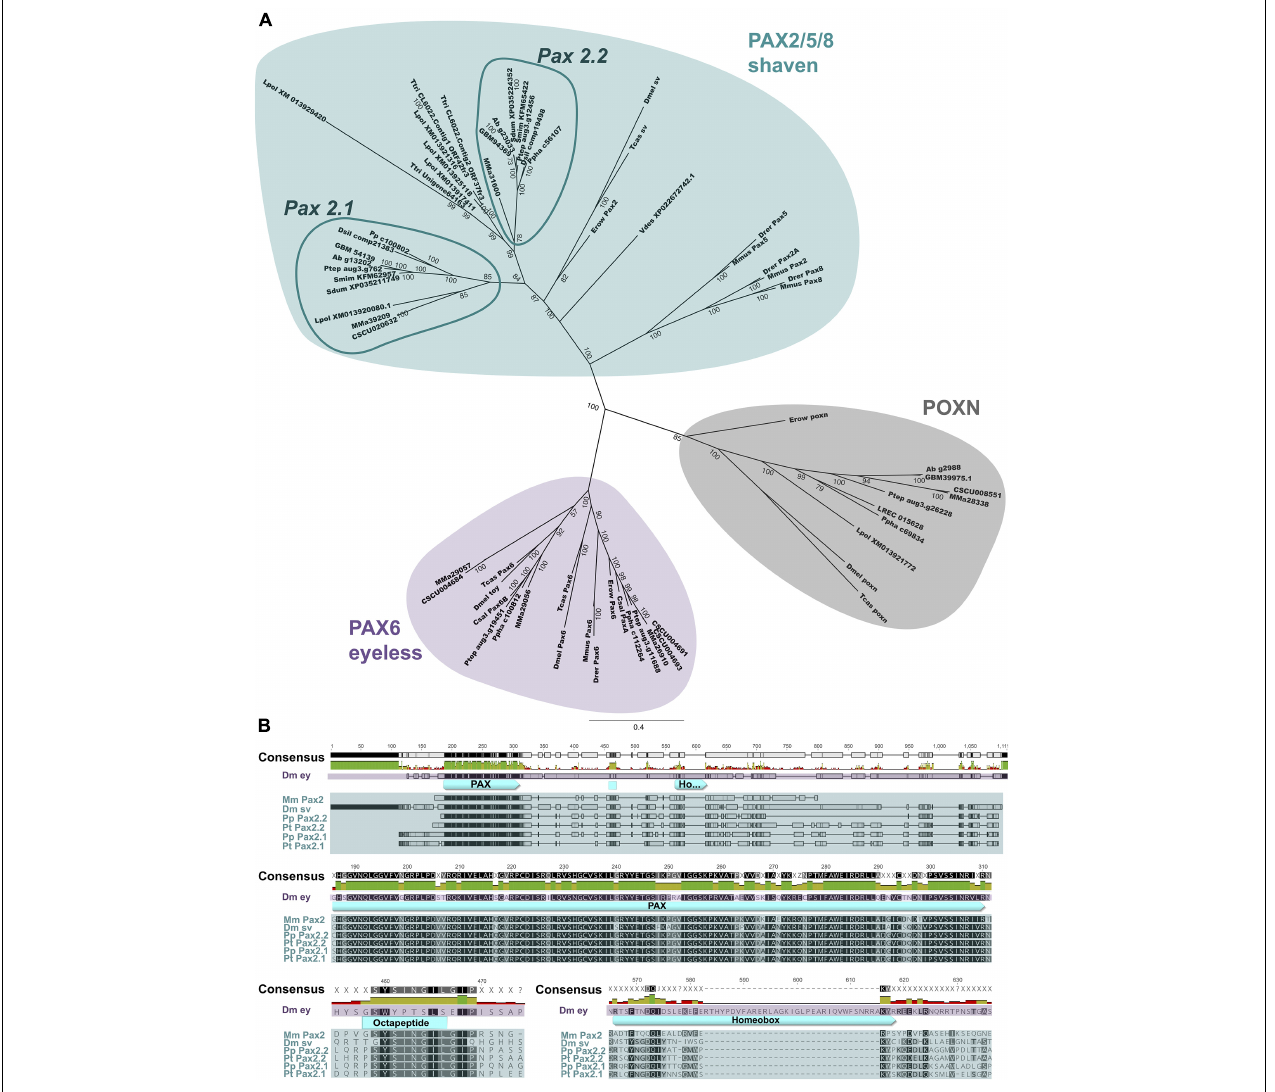
FIGURE 1 | Phylogenetic analysis and protein alignment of selected Pax genes. (A) Bayesian Markov chain Monte Carlo analysis depicted as unrooted 50% majority rule consensus tree. Branch lengths indicate expected substitutions per site. Labels at the tree edges represent clade credibility values, which are a measure of the posterior probability of each clade in the tree. Turquoise indicates the PAX2/5/8 cluster ( D. melanogaster ortholog is shaven ), purple shading marks Pax6 ortholog group ( D. melanogaster ortholog is eyeless ), and the Poxn cluster is highlighted in gray. The arachnopulmonate specific Pax2.1 and Pax2.2 groups within the Pax2/5/8 cluster are highlighted with dark turquoise circles. (B) Protein alignment of selected sequences (Dm ey, D. melanogaster eyeless (purple); Mm Pax2, M. musculus Pax2 ; Dm sv, D. melanogaster shaven ; Pp Pax2.1, P. phalangioides Pax2.1 ; Pt Pax2.1, P. tepidariorum Pax2.1 ; Pp Pax2.2, P. phalangioides Pax2.2 ; Pt Pax2.2, P. tepidariorum Pax2.2 (turquoise). PAX domain, as well as octapeptide and homeobox domains are highlighted and shown in detail. Species abbreviations and accession numbers or genomic and transcriptomic resources are summarized in Supplementary Table 2